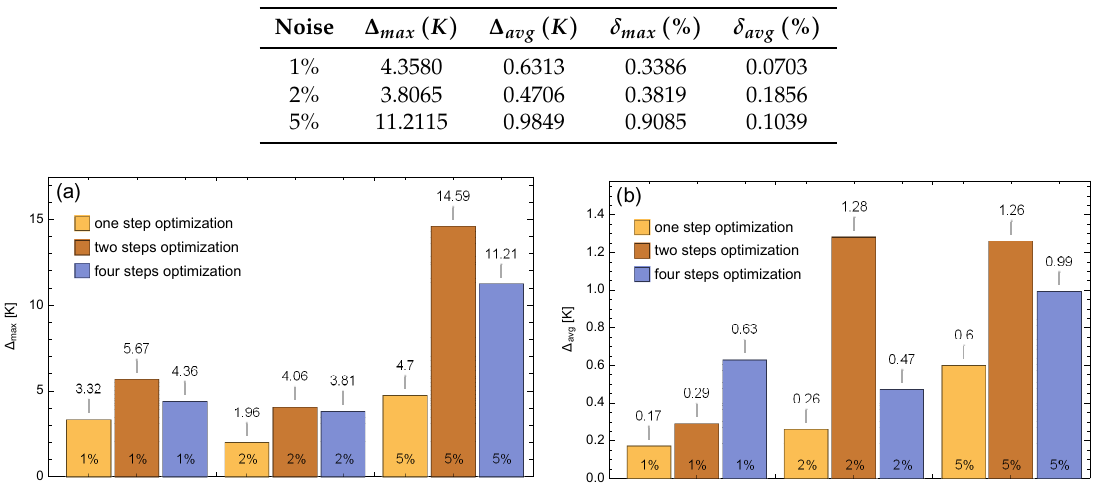
Table 8. Errors of temperature reconstruction in the control points obtained for measurements read at every 0.01m (four steps optimization).